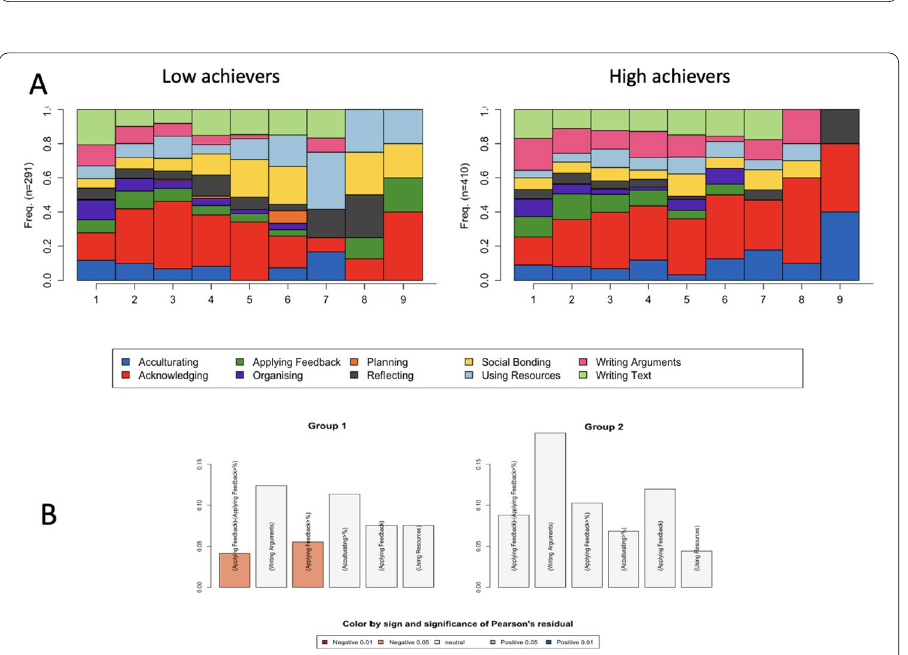
Fig. 3 Sequence mining map (to the left) and process map (to the right) of most dominant contemporaneous SRL tactics in the peer interaction